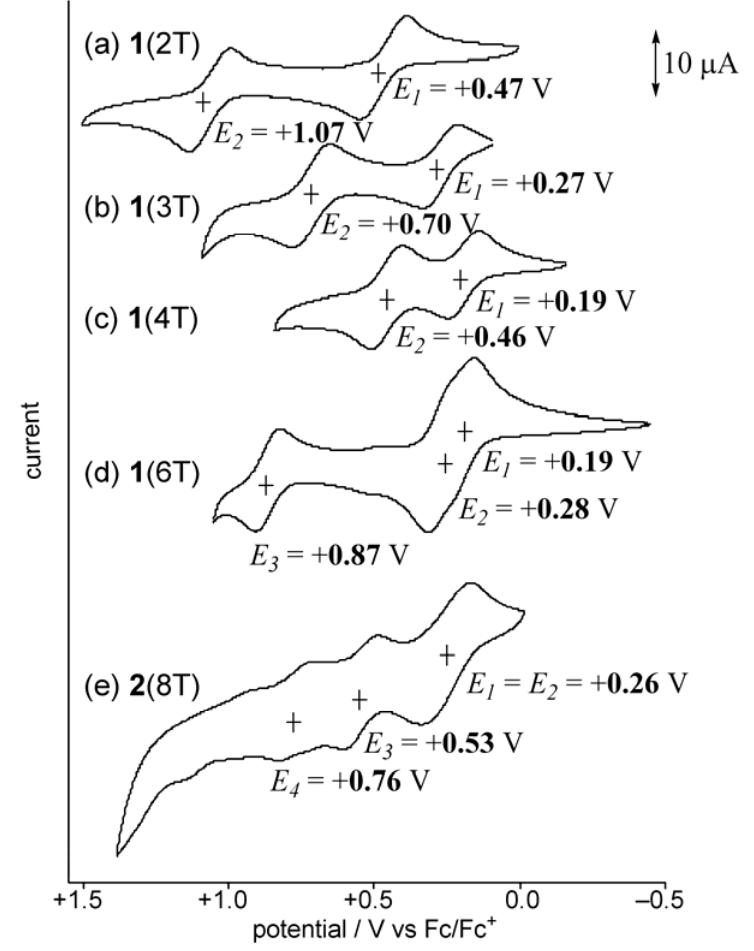
Figure 3. Cyclic voltammograms of 1 (nT) (n = 2, 3, 4, 6) and 2 (8T) in CH TBAPF (0.1M) with scan rate 0.1 V s  1 : (a) 1  (2T) 6